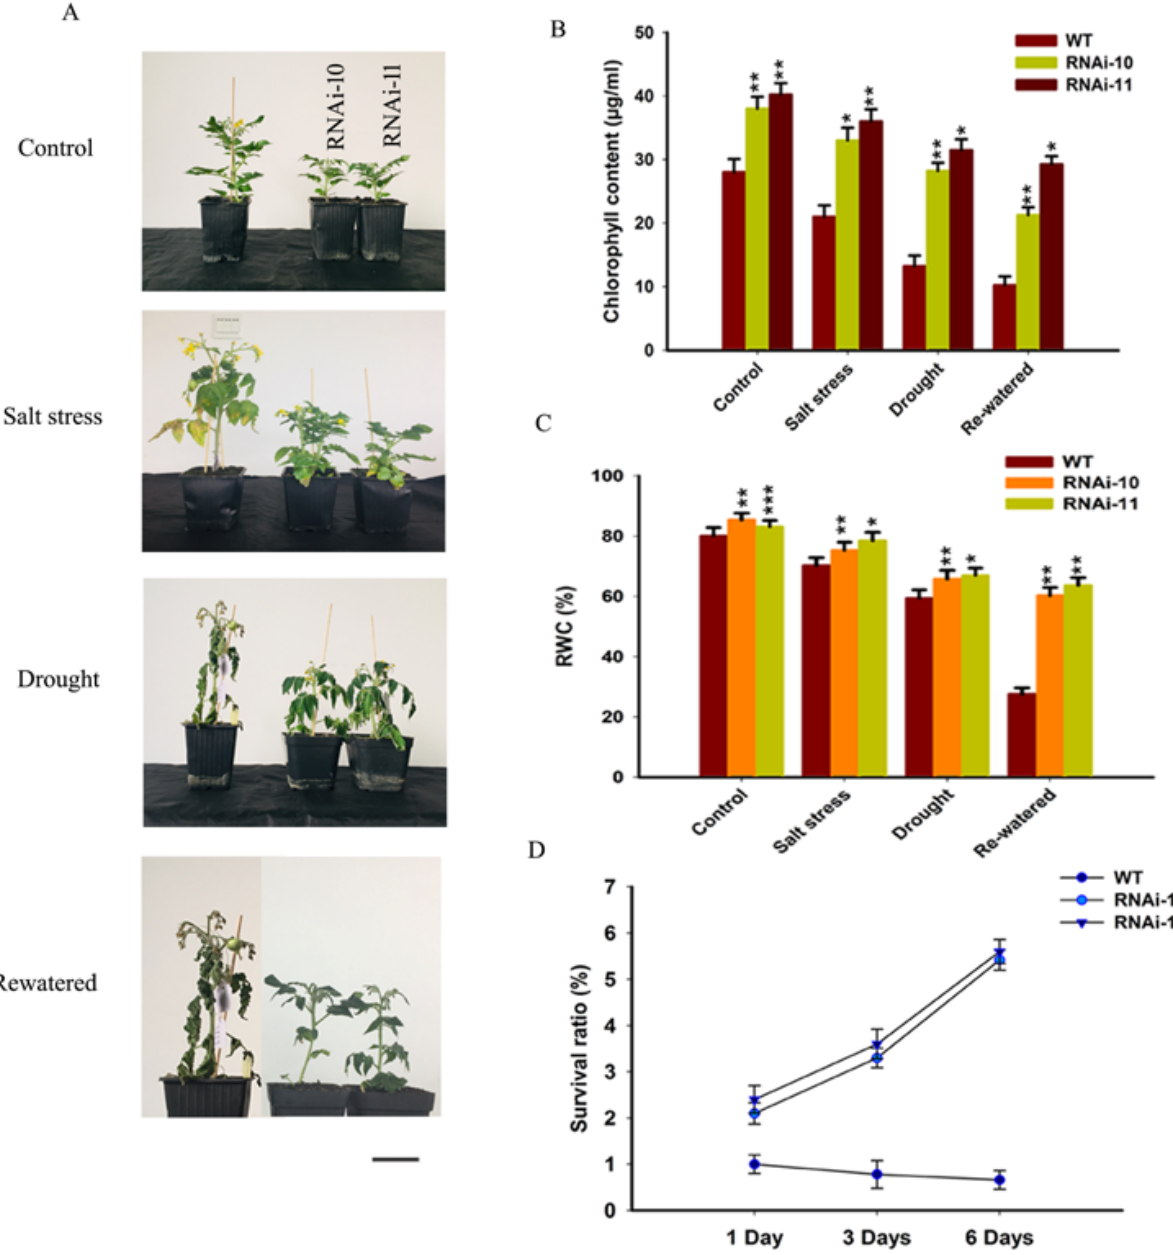
Figure 7. Down-regulation of SlGRAS10 enhances tolerance to salt and drought stress treatment. ( A ) Photographs of representative plants after one month of control, salt stress, drought stress, and re-watered treatments compared to control plants. Scale bar = 5 mm. ( B ) Total chlorophyll content of SlGRAS10 -RNAi (L10, L11) and wild-type plants are shown in ( A ) under control, salt, and drought stresses. ( C ) Relative water content (RWC) of SlGRAS10 -RNAi (L10, L11) and wild-type plants are shown in ( A ) under control, salt, and drought stresses. ( D ) Survival ratio of drought stress plants of WT and SlGRAS10 -RNAi lines after re-watered at different time points (1 Day re-watered, 3 Days re-watered, and 6 Days re-watered) ( n = 20). The date represents the mean ± SE of three independent replicates. *, **, *** indicates a significant difference ( p < 0.05, p < 0.01, p < 0.001) between transgenic and wild-type plants.